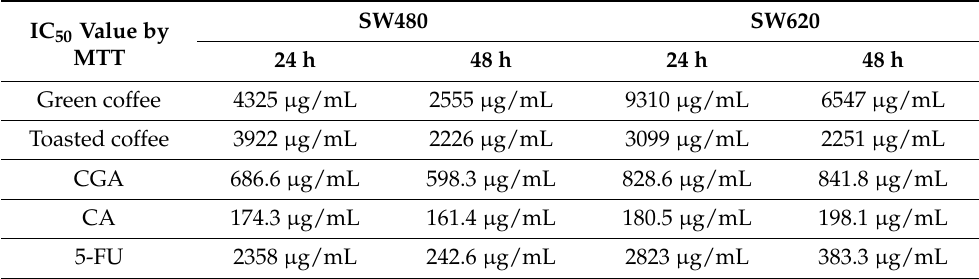
Figure 3. Cytotoxicity activity measured by MTT in the colorectal cancer cell lines SW480 and SW 620. GC ( A ), TC ( B ), CGA ( C ), CA ( D ), and 5-FU ( E ). Values are expressed as mean ± SEM of at least three independent experiments. Two-way ANOVA, difference to non-treated cells, * p ≤ 0.05, ** p ≤ 0.01, *** p ≤ 0.001, **** p ≤ 0.00001. Table 1. IC 50 values determined by MTT and SRB methods on SW480 and SW620 cells treated with green (GC) and toasted coffee (TC) extracts, chlorogenic acid (CGA), caffeic acid (CA), and 5-fluorouracil